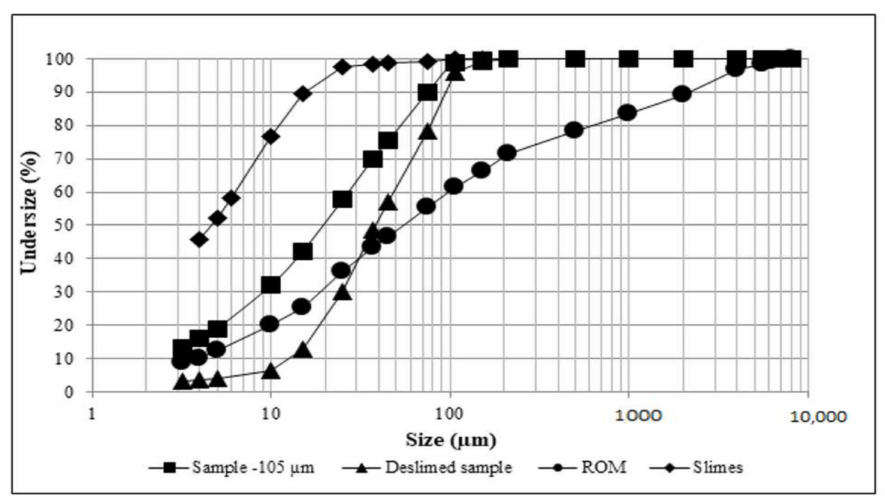
Figure 2. Size distribution curves of the amphibolitic itabirite samples studied: run of mine (ROM), − 105 µ m, deslimed and slimes.